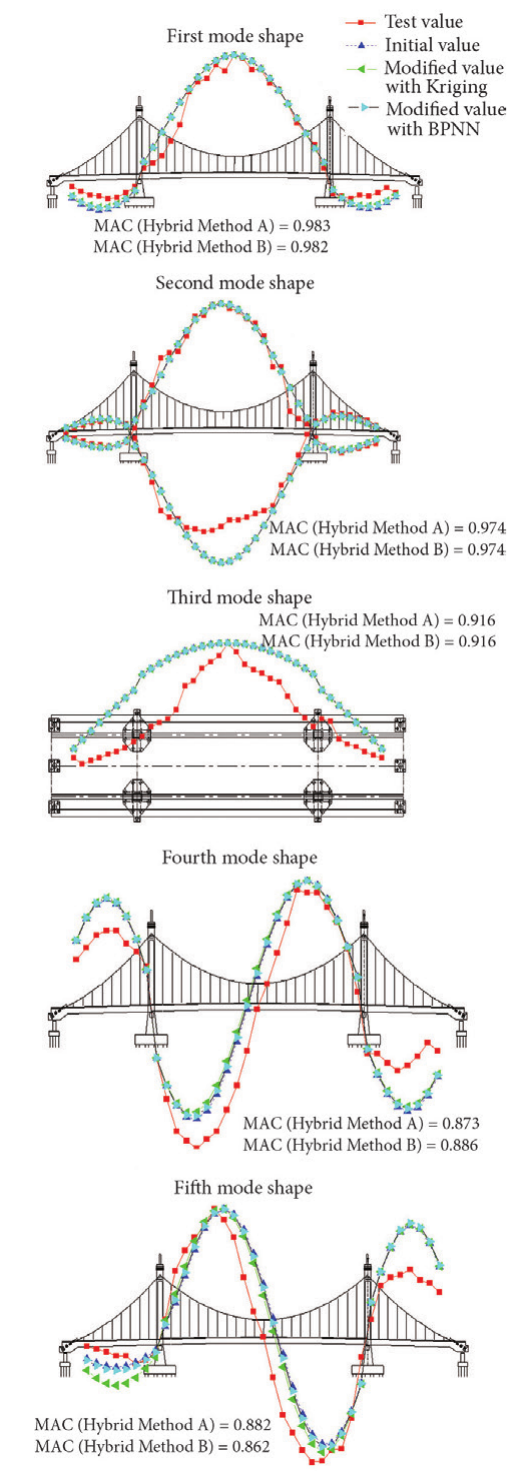
Fig. 9. Comparison of mode shape among test, initial model, and modified